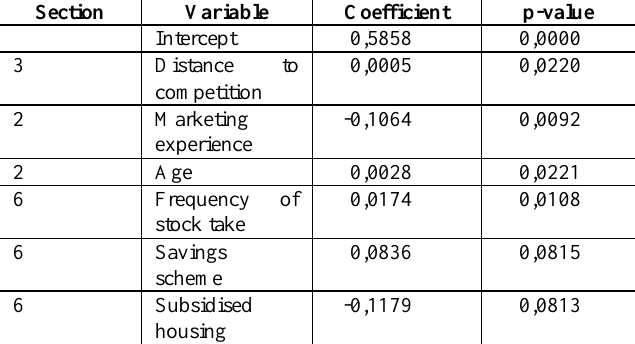
Table 5: Results of stepwise regression